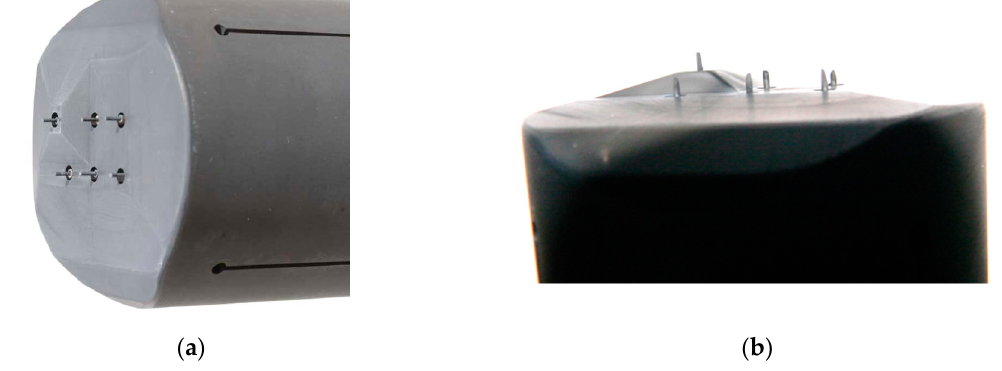
Figure 1. Photo of the Innsbruck-Padua Probe (InnPadP) before ( a ) and after ( b ) numerous insertions into the scrape-off layer (SOL) of the Axial Symmetric Divertor Experiment (ASDEX) Upgrade [8,9,12]. ( a ) The InnPadP graphite casing had a diameter of 50 mm and a length of 115 mm. Its six probe pins (also of graphite) are visible on the left side of the probe casing, each pin consisting of graphite with 1 mm diameter and 3 mm protruding length above the front side of the probe casing. ( b ) The front side of the InnPadP after numerous insertions into the ASDEX Upgrade: the “sharpening” of the probe pins by sputtering is clearly visible, while their length is almost unaltered.